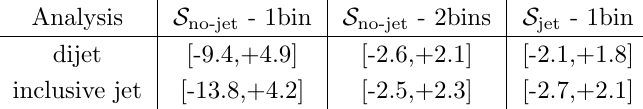
Projected 95% CL constraints on the Z parameter for the 8 TeV LHC with 20 fb (cid:0) 1 of integrated luminosity. The two rows correspond to the limit extracted from either the dijets or the inclusive jet analysis, respectively, while the three di(cid:11)erent columns correspond to di(cid:11)erent PDF sets or di(cid:11)erent number of rapidity bins included in the